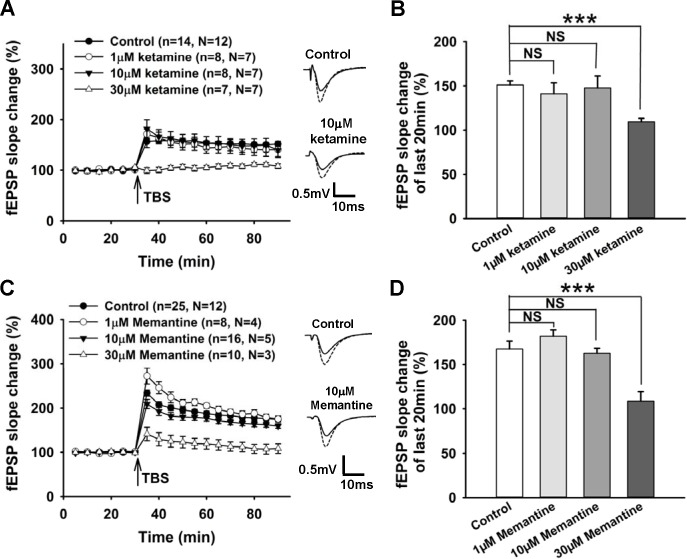
Low concentrations of ketamine and memantine did not affect LTP in the mouse hippocampal CA1 region, while higher concentrations of ketamine and memantine inhibited LTP.A, Effects of different concentrations of ketamine (1 μM; 10 μM; 30 μM) on LTP. Baseline of fEPSP (normalized to the average value of baseline) was recorded for 30 min followed by TBS (indicated by the arrow), and another 1 hr fEPSP was recorded after induction. Ketamine was applied before the baseline recording. Insets, representative fEPSP traces of 5 min before TBS (solid curve) over fEPSP traces of 55–60 min (dotted curve) after TBS for control group (upper) and 10 μM ketamine group (lower). B, Summarized data showing average slope change (normalized to baseline value) of the last 20 min recordings from each group. C, Effects of different concentrations of memantine (1 μM; 10 μM; 30 μM) on LTP. Memantine was applied before the baseline recording. Insets, representative fEPSP traces for control group (upper) and 10 μM memantine group (lower). D, Summarized data showing average slope change (normalized to baseline value) of the last 20 min recordings from each group. All data are expressed as mean ± SEM; **p<0.01, ***p<0.001, NS, no significant difference.